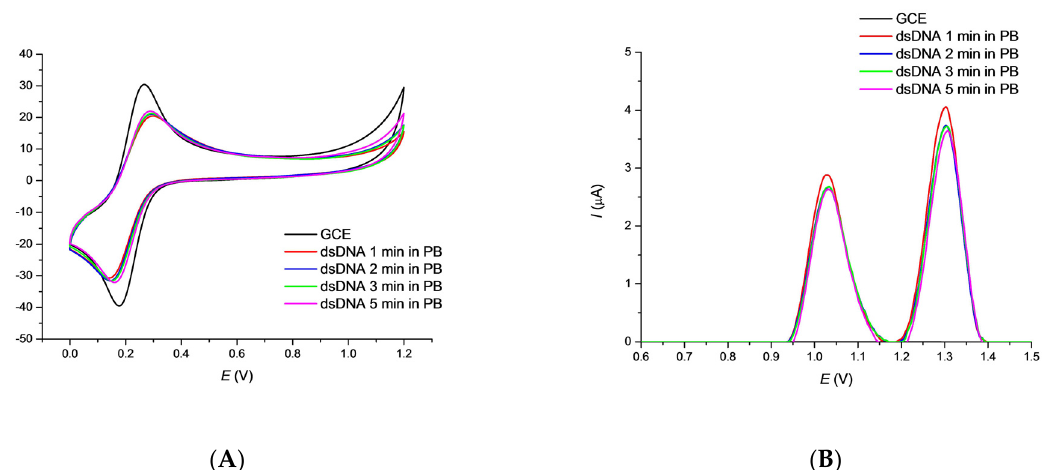
Figure 1. CV curves for 1 × 10 − 3 mol·L − 1 redox indicator ( A ) and SWV ( B ) curves obtained for the bare GCE and DNA/GCE biosensor in 0.1 mol·L − 1 PB pH 7.4 after treatment in the supporting electrolyte for a given time. Conditions: CV step potential 2 mV, scan rate 100 mV·s − 1 ; SWV amplitude 20 mV, frequency 50 Hz, step potential 4 mV and scan rate 200 mV·s − 1 .